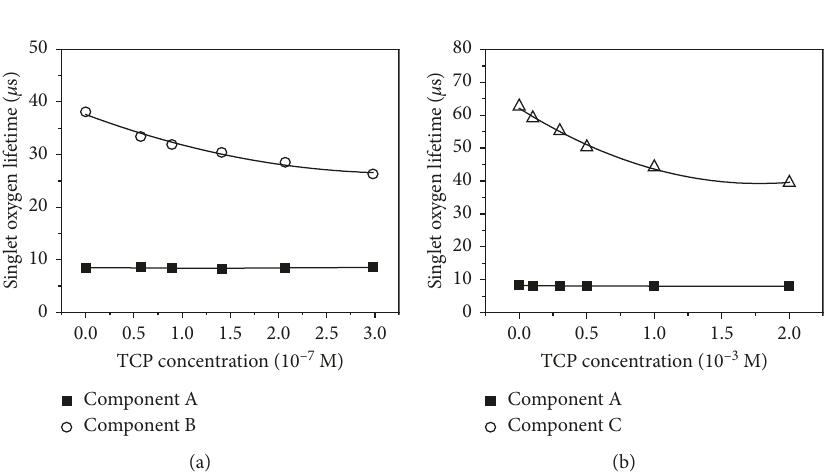
Figure 4: Plots of the singlet oxygen lifetime of (a) components A and B vs. TCP surface layer concentration, and (b) components A and C vs. TCP concentration in